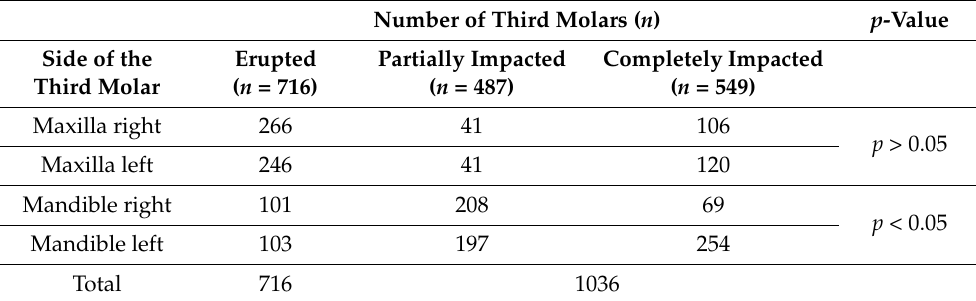
Table 3. Distribution of erupted, partially impacted, and completely impacted third molars.